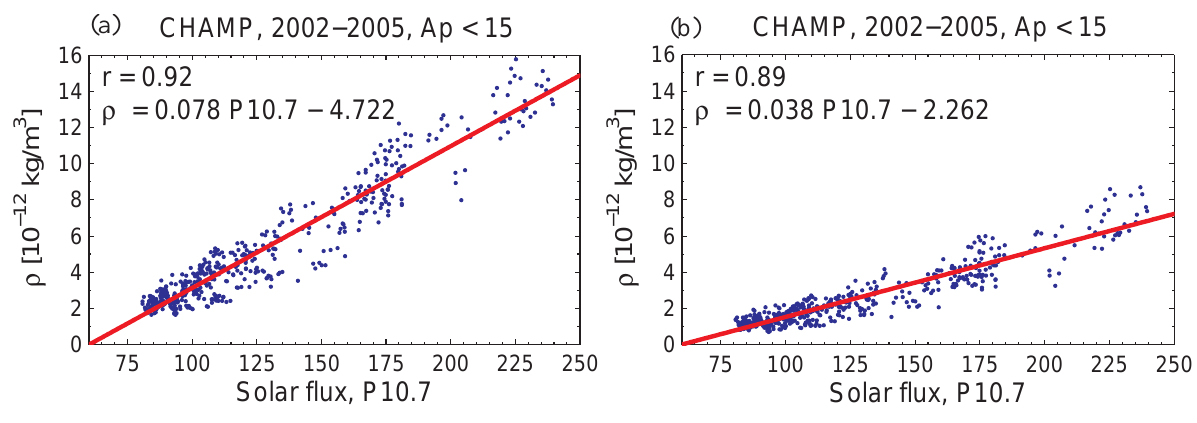
Fig. 3. Correlation between CHAMP-derived densities and the solar flux level (P10.7), (a) for the day side (10:30–16:30LT) and (b) for the night side (22:30–04:30LT) density. The density readings are longitudinally averaged daily means.